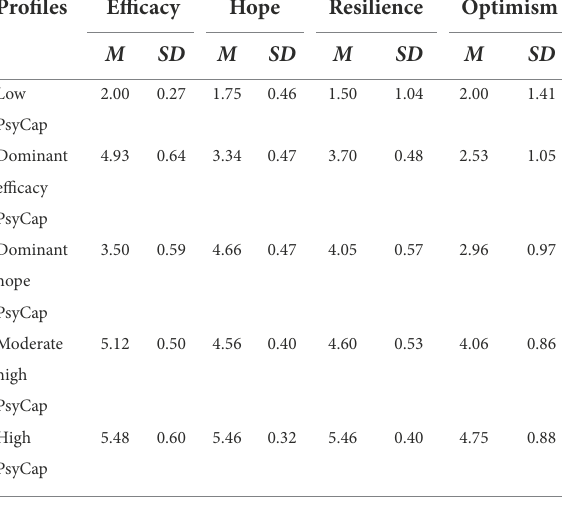
TABLE 3 Means and standard deviation of PsyCap dimensions across profiles at Time